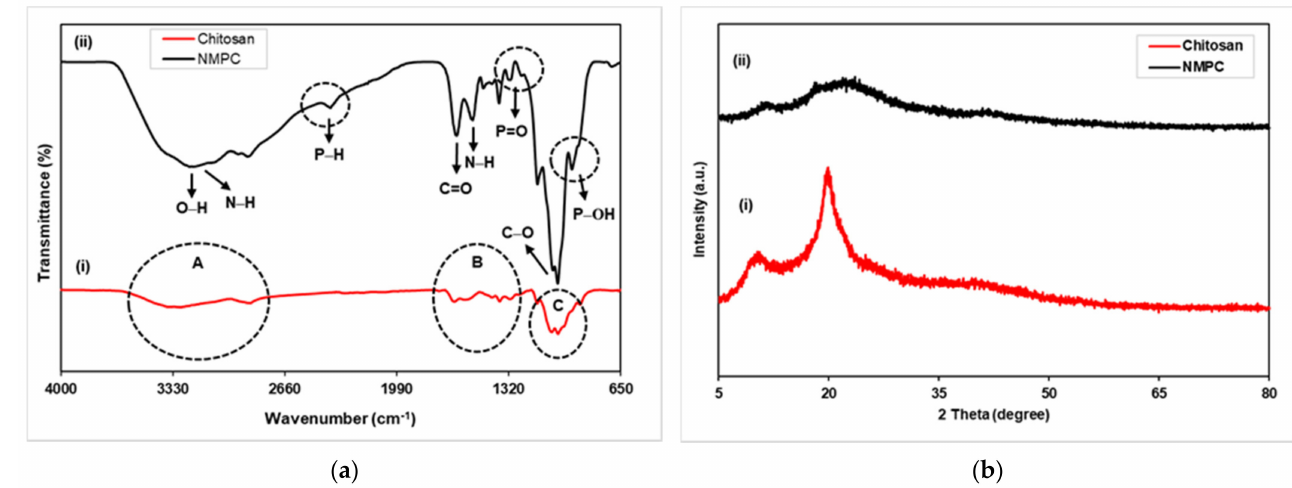
Figure 1. ( a ) FTIR spectra of chitosan and N -methylene phosphonic chitosan (NMPC) and ( b ) XRD diffractograms of chitosan and